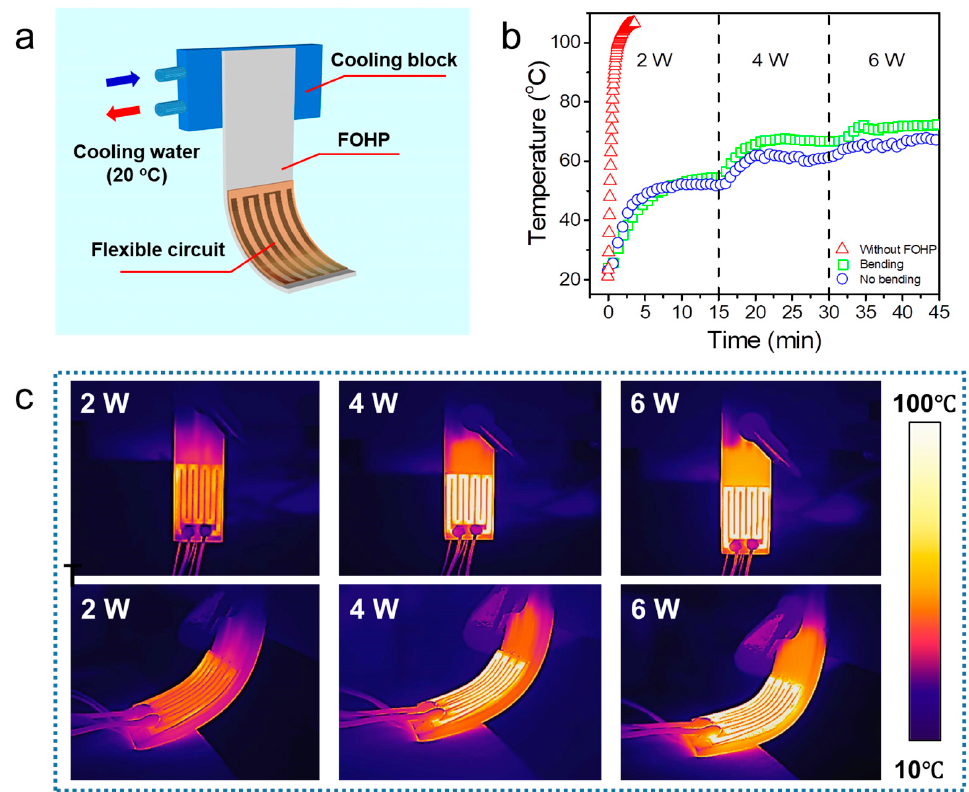
Figure 7. Thermal management of a flexible printed circuit by the 3D-printed FOHP. ( a ) Schematic of thermal management of a flexible printed circuit by a FOHP. ( b ) Surface temperature variation of the flexible printed circuit managed by the FOHP over time. ( c ) IR images showing different thermal performances by the FOHP at different heating power inputs.